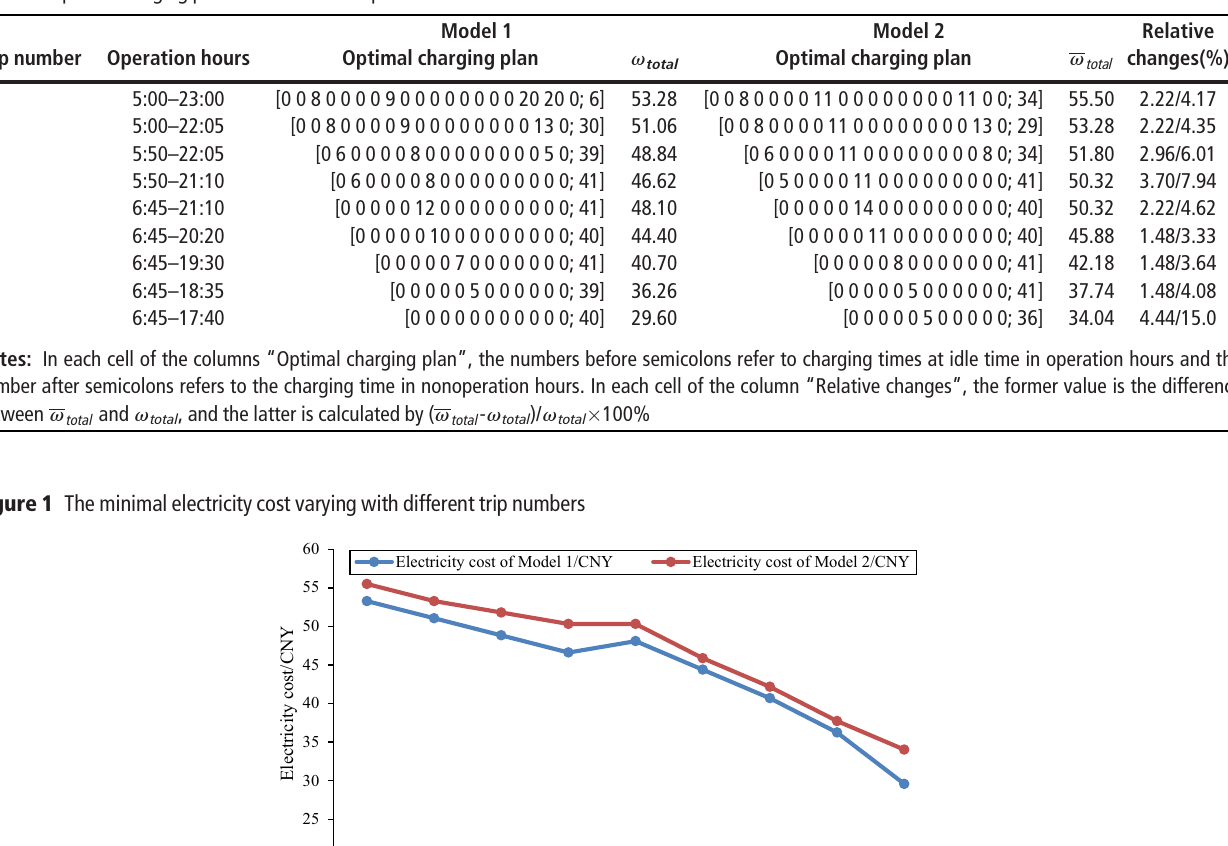
Table 9 Optimal charging plans with different trip